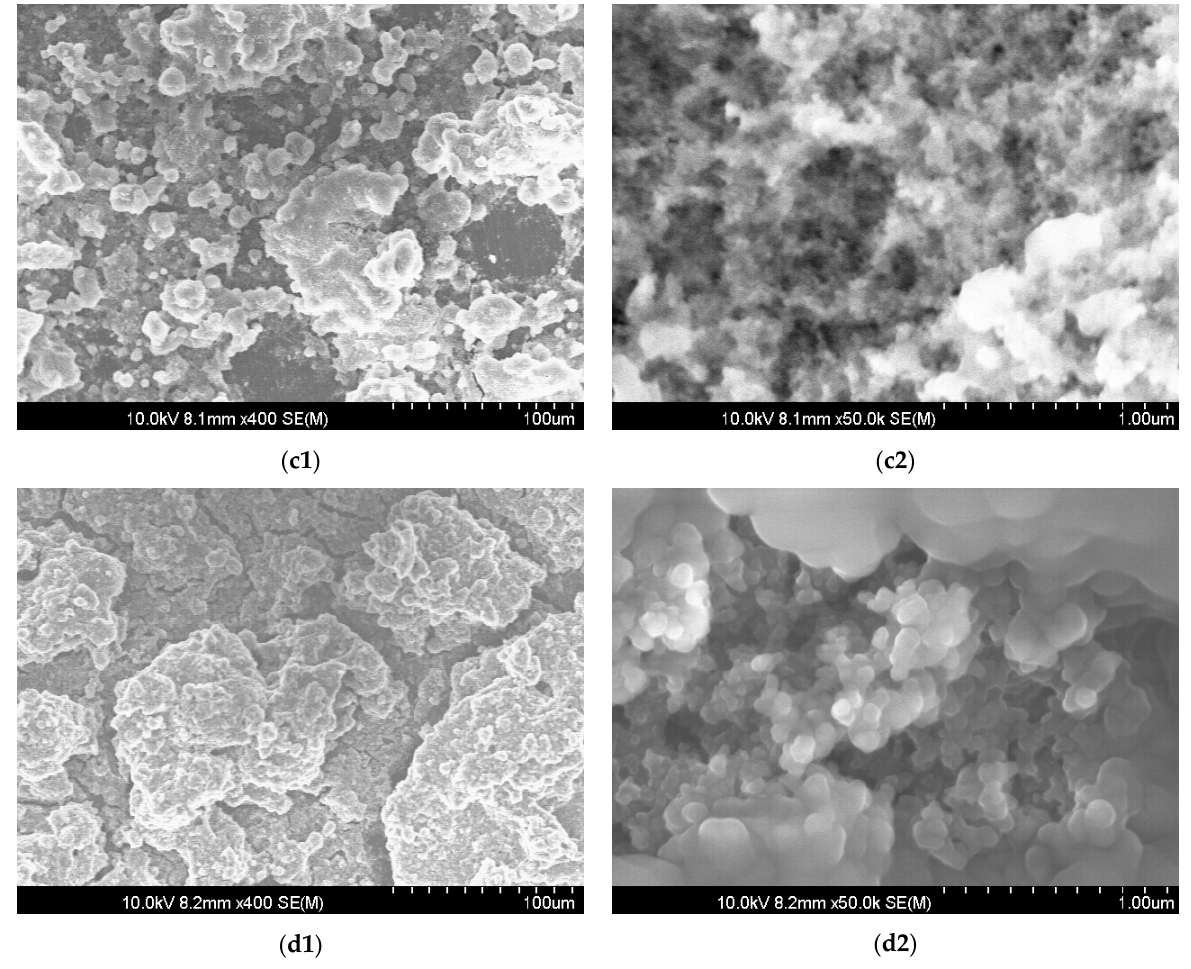
Figure 6. SEM images showing the morphology of the ( a ) initial state of the exemplary new-coated and ( b ) old-coated samples before condensation experiments, as well as ( c ) new-coated sample N1 and ( d ) old-coated sample O1 after condensation experiments at different magnifications: (1) ×400 and (2) ×50,000.